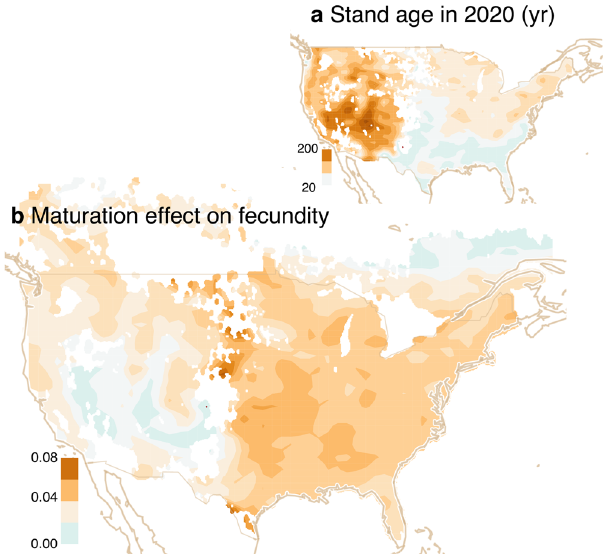
Fig. 7 Size and maturation effects on fecundity. a Stand age variable in FIA data and b positive effect of maturation for increasing fecundity in the eastern continent. In the West, maturation does not contribute to rising fecundity because large trees are predominantly [mature] Again, maps in Fig. 5 show mean proportionate effects for all trees on an inventory plot.